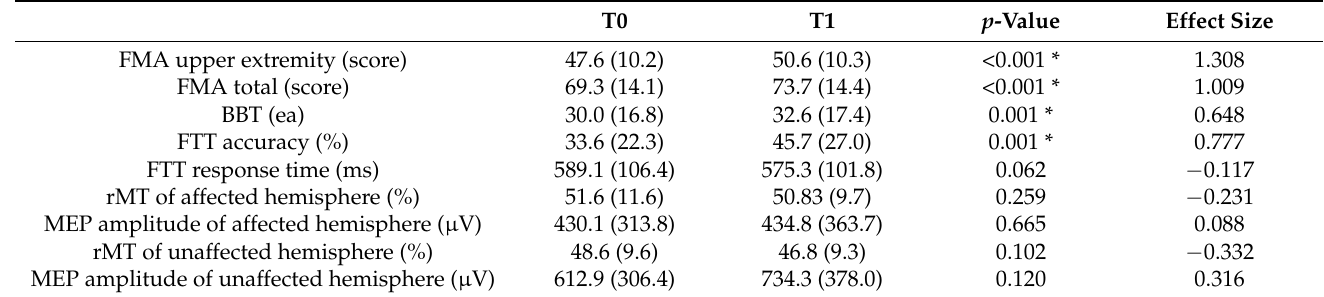
Table 3. Changes in behavioral test and neurophysiological measurement